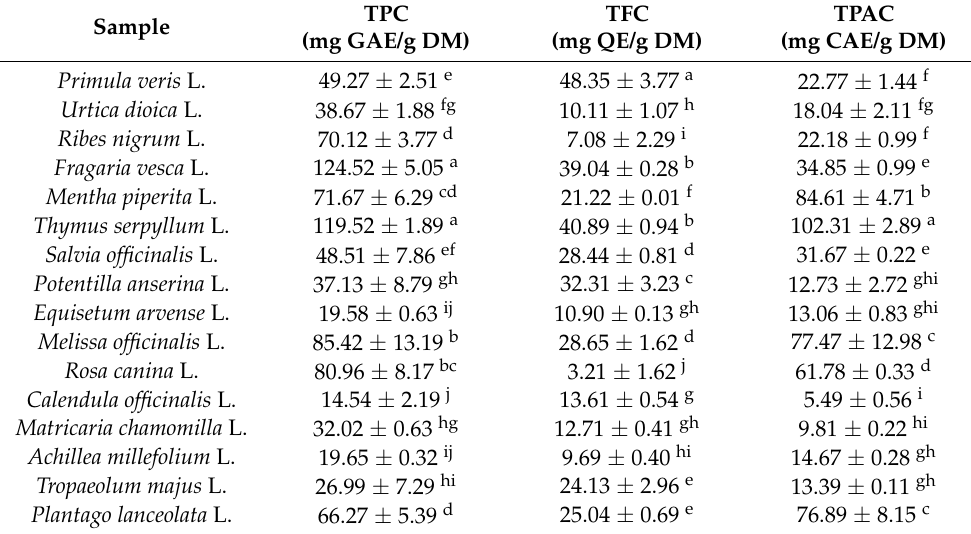
Table 2. Total polyphenol, flavonoid and phenolic acid contents of tested medicinal